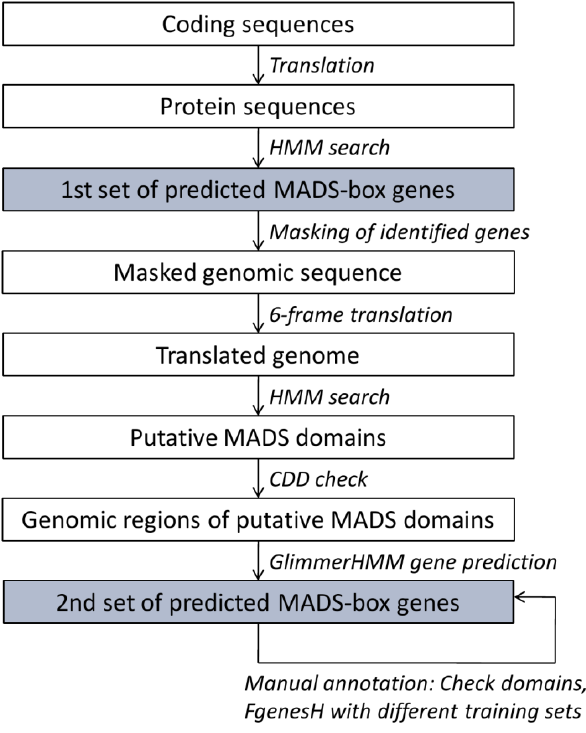
Figure 3. Alignment of exemplary MADS domains from all types and groups of MADS-domain proteins from the species Oryza sativa (OsMADS), Populus trichocarpa (PtMADS), Gnetum gnemon (GGM), and Arabidopsis thaliana (all other gene names). The (cid:79)(cid:68)(cid:69)(cid:72)(cid:79)(cid:79)(cid:76)(cid:81)(cid:74)(cid:3)(cid:68)(cid:73)(cid:87)(cid:72)(cid:85)(cid:3)(cid:87)(cid:75)(cid:72)(cid:3)(cid:88)(cid:81)(cid:71)(cid:72)(cid:85)(cid:86)(cid:70)(cid:82)(cid:85)(cid:72)(cid:3)(cid:71)(cid:72)(cid:81)(cid:82)(cid:87)(cid:72)(cid:86)(cid:3)(cid:87)(cid:75)(cid:72)(cid:3)(cid:74)(cid:85)(cid:82)(cid:88)(cid:83)(cid:29)(cid:3)(cid:48)(cid:68)(cid:15)(cid:3)(cid:48)(cid:302)(cid:30)(cid:3)(cid:48)(cid:69)(cid:15)(cid:3)(cid:48)(cid:533)(cid:30)(cid:3)(cid:48)(cid:74)(cid:15)(cid:3)(cid:48)(cid:534)(cid:30)(cid:3)(cid:48)(cid:44)(cid:46)(cid:38)(cid:54)(cid:15)(cid:3)(cid:48)(cid:44)(cid:46)(cid:38)(cid:13) , and MIKCC, MIKC C . The alignment is colored according to the Clustal X color scheme